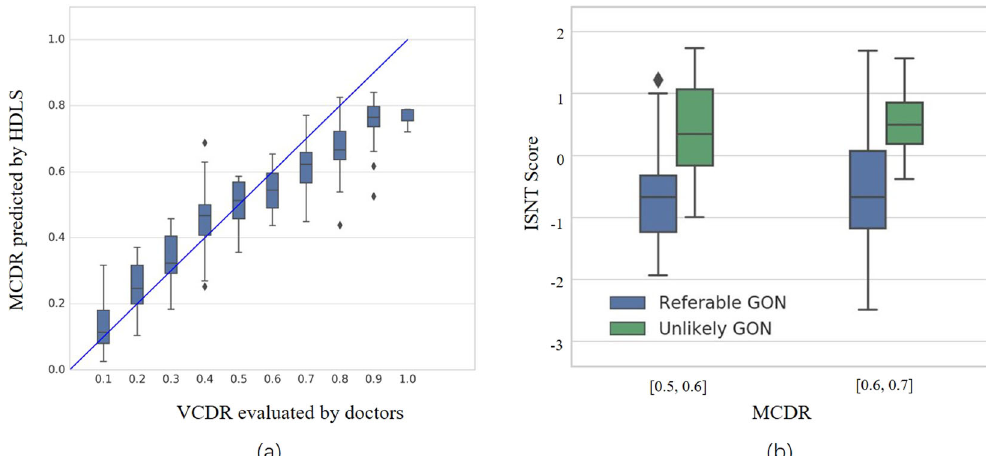
Fig. 4 Evaluation of ef fi cacy of MCDR and ISNT score. a Comparison of MCDR predicted by hierarchical deep learning system (HDLS) with VCDR evaluated by the glaucoma expert. b Comparison of ISNT score obtained by HDLS between referable GON and unlikely GON. The median (50th percentile) is represented by the horizontal centerline, and the 25th and 75th percentiles as the lower and upper limits of the box. The upper and lower horizontal bars represent the maximum and minimum values, respectively, of a 1.5 interquartile range. The diamond symbols represent outliers. Outliers were denoted in the fi gure because they resided outside of the 1.5 interquartile range. MCDR mean cup-to-disk ratio, VCDR vertical cup-disc ratio, ISNT inferior, superior, nasal, temporal; GON glaucomatous optic neuropathy.